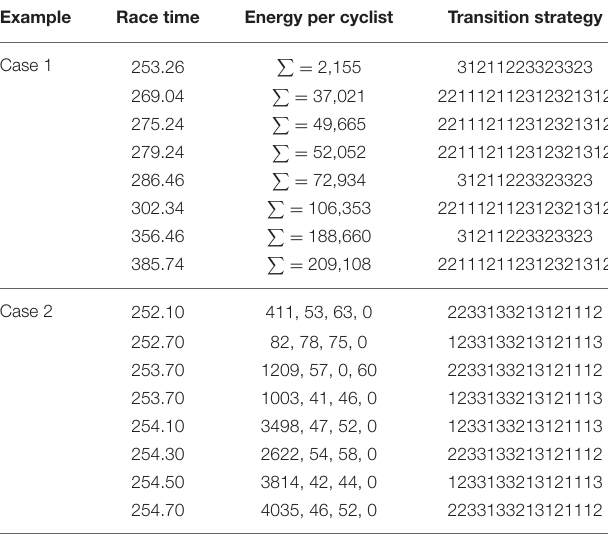
TABLE 3 | Exemplary outputs of the nested